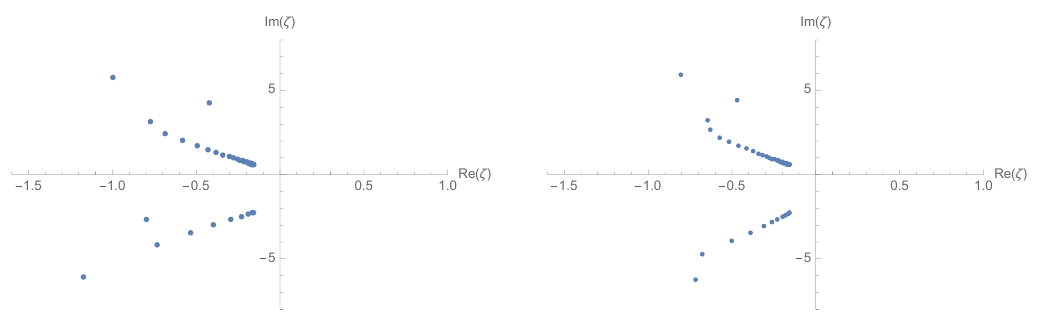
( (cid:16) ) in the Thurston manifold (3.35) for n max = 40 (left) and max